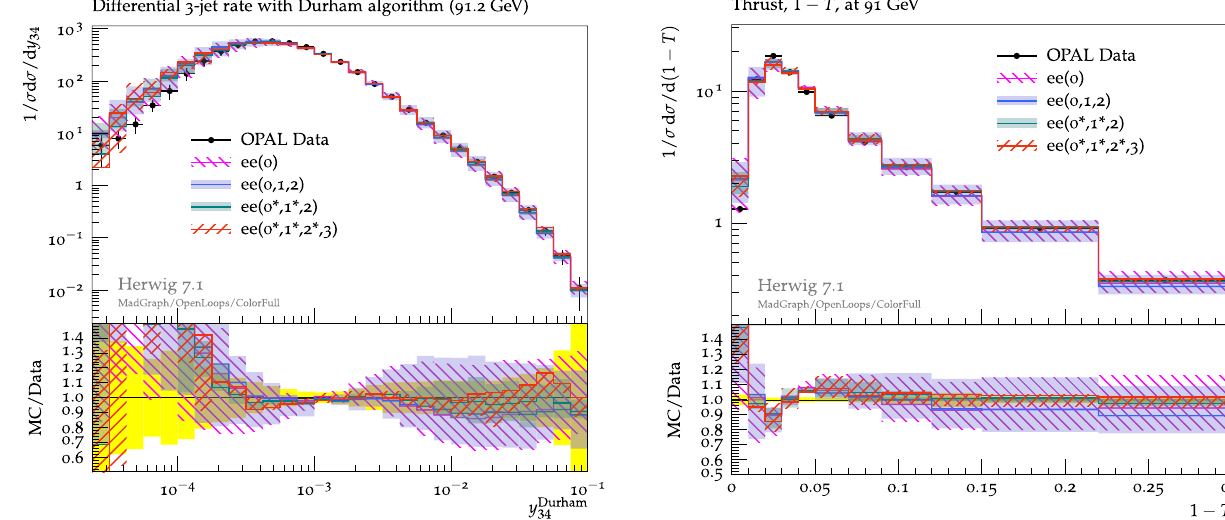
Fig. 17 The thrust 1 − T as measured at LEP [68] compared to vari- ous simulations with increasing inclusion of NLO corrections to higher multiplicities